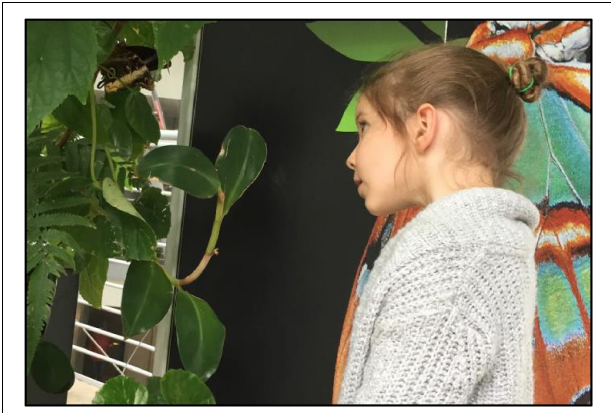
FIGURE 1 | A child looks intently at a butterfly, becoming curious about the many things she wonders based on her